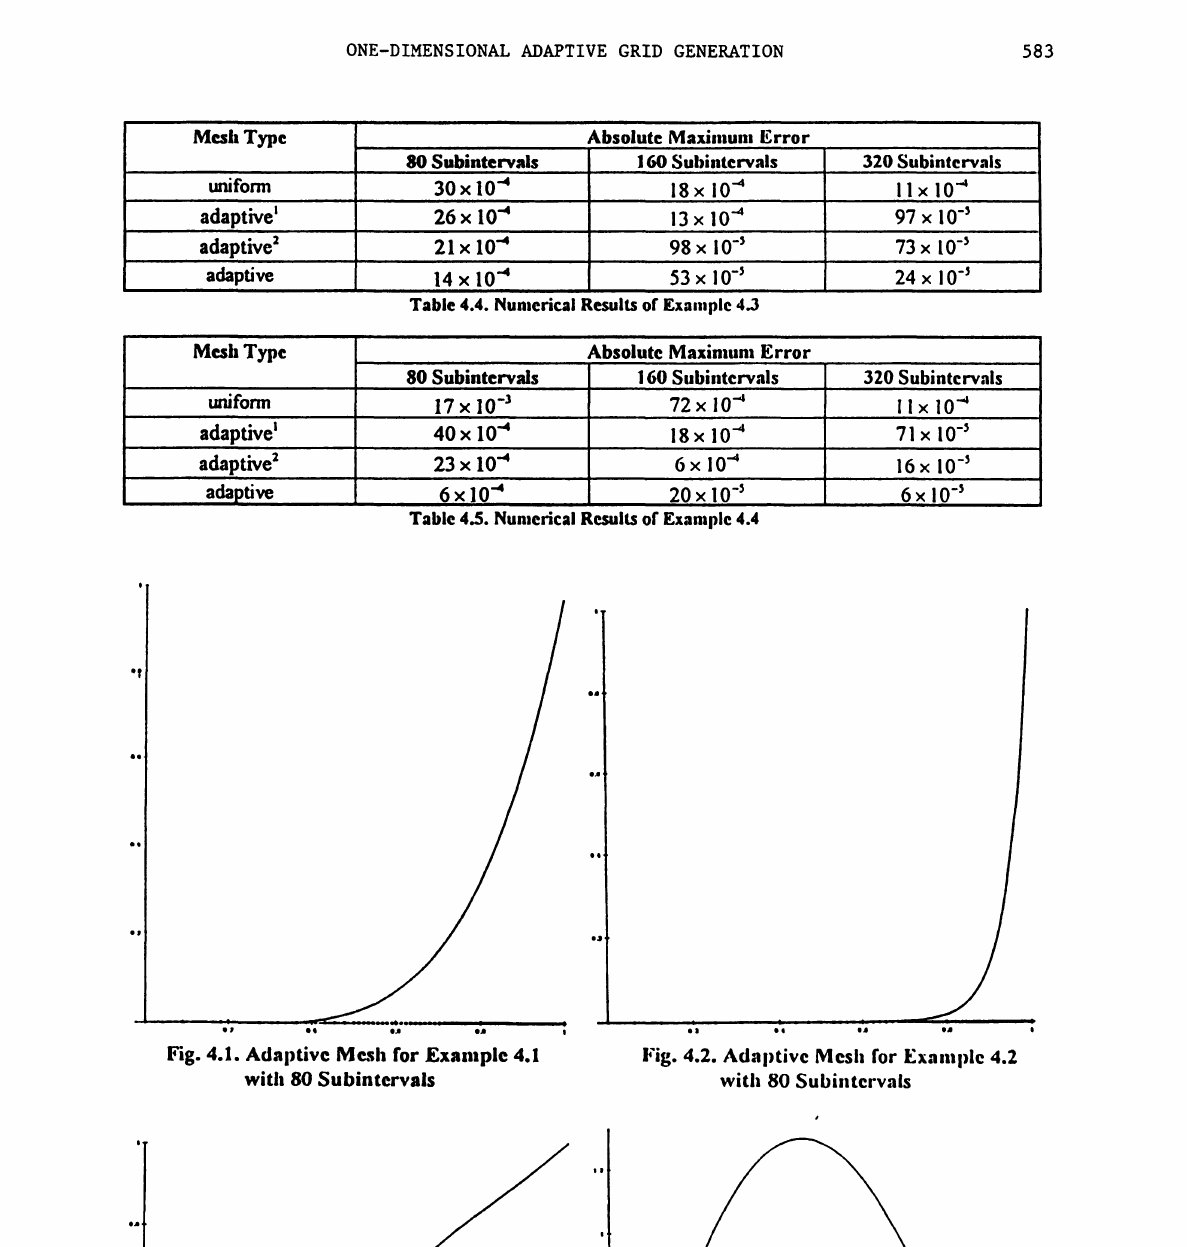
Fig. 4.2. Adaptive Mesh for Example 4.2 with 80 Subintervals